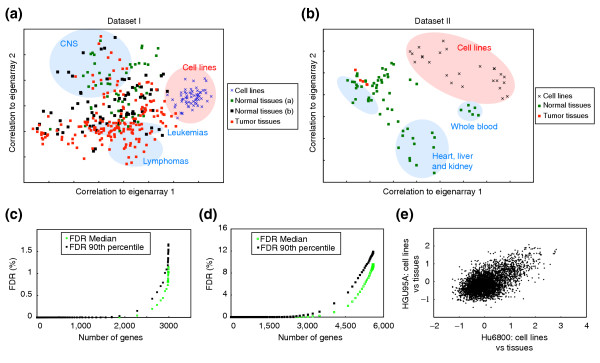
The gene-expression profiles of cell lines compared to normal and tumor tissues. (a) Projection of each sample in dataset I into SVD space drawn by the correlation of each sample to SVD eigenarray 1 (x-axis) and 2 (y-axis). The normal tissue samples of CNS origin from two laboratories (green squares, Hsiao et al [17]; black squares, Ramaswamy et al. [16]) were overlapping, as well as the tumor tissue samples (red squares, Ramaswamy et al. [16]). The cell lines were separated from tissue samples by the first SVD eigenarray. Samples of lymphoma and leukemia origin were also separated in the SVD analysis. (b) Projection of each sample in dataset II into the SVD space drawn by the correlation of each sample to SVD eigenarray 1 (x-axis) and 2 (y-axis). The cell lines (crosses) were separated from tissue samples. Whole blood samples were distinctly clustered close to the cell lines. (c) Other separation of normal samples. Significance analysis of microarrays (SAM) was used to identify differentially expressed genes between cell line and tissue samples in dataset I. The number of statistically significant genes (x-axis) as a function of the median and 90th percentile of the FDR (y-axis) estimated based on 1,000 permutations. (d) SAM analysis of cell line versus tissue samples in dataset II. Identical parameters as in (c). (e) Plot of the degree of differential expression between cell lines and tissues for each gene in dataset I (x-axis) versus dataset II (y-axis) respectively. The degree of differential expression was measured using the signal-to-noise metric [23].